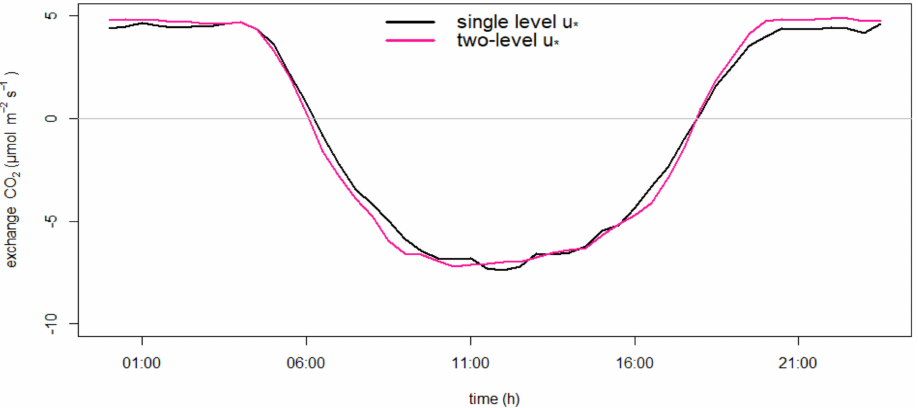
Figure 6. Mean diurnal variation of CO 2 exchange (NEE) based on single- and two-level u* filtered data for the year 2019.